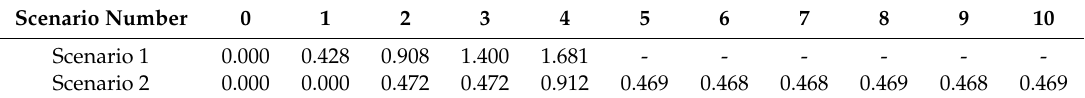
Table 3. Camera movement angles ( ◦ ) in Scenario 1 and Scenario 2.